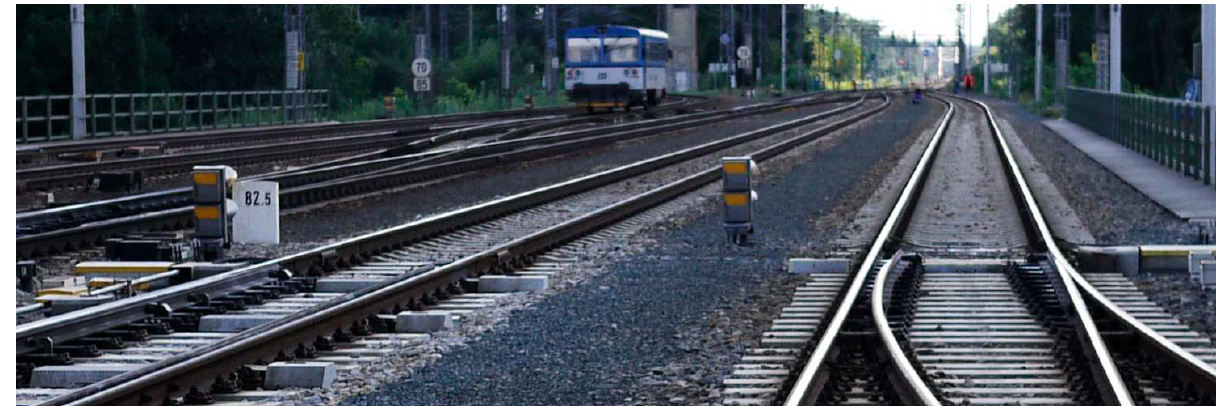
Figure 3. View of the track on the bridge in the direction from fixed